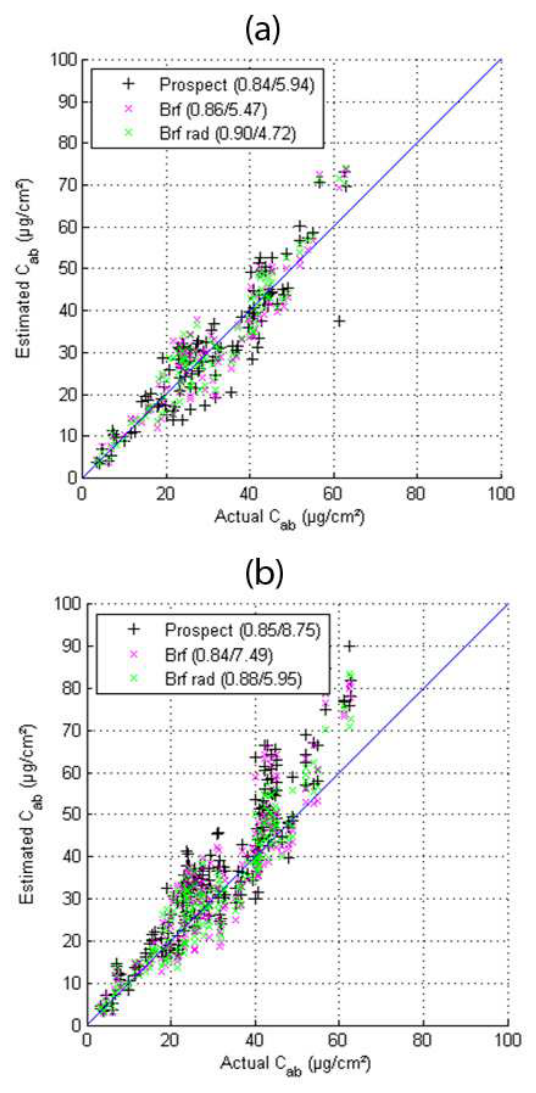
Figure 1: C ab estimation results: (a) flat leaves, and (b) tilted leaves. For each method, the R 2 and RMSE are indicated in